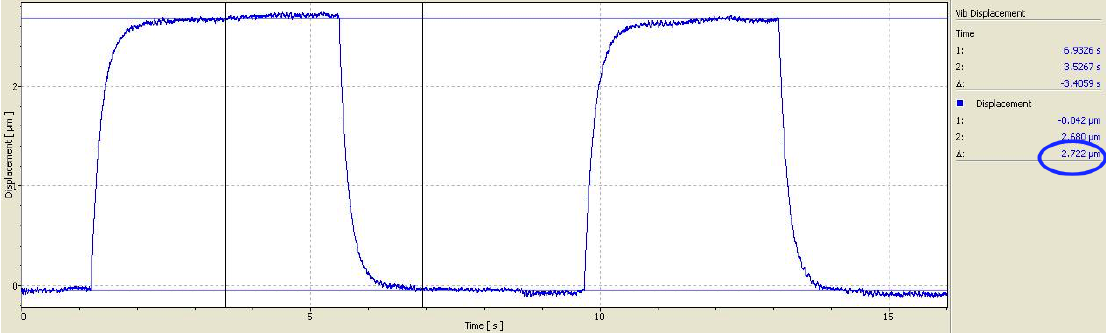
Figure 4. Experimentally measured wire flexure under a current pulse train with amplitude 6A.